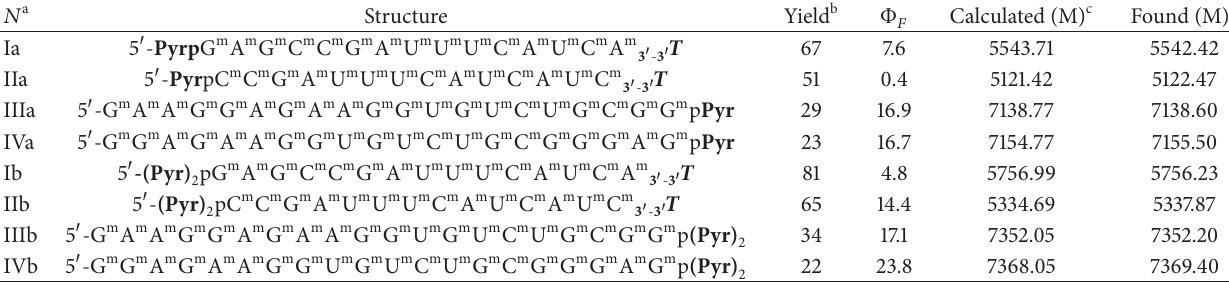
Table 1: Mono- and bis-pyrene-labeled oligo(2 󸀠 -O-methylribonucleotides). 𝑁 a Structure